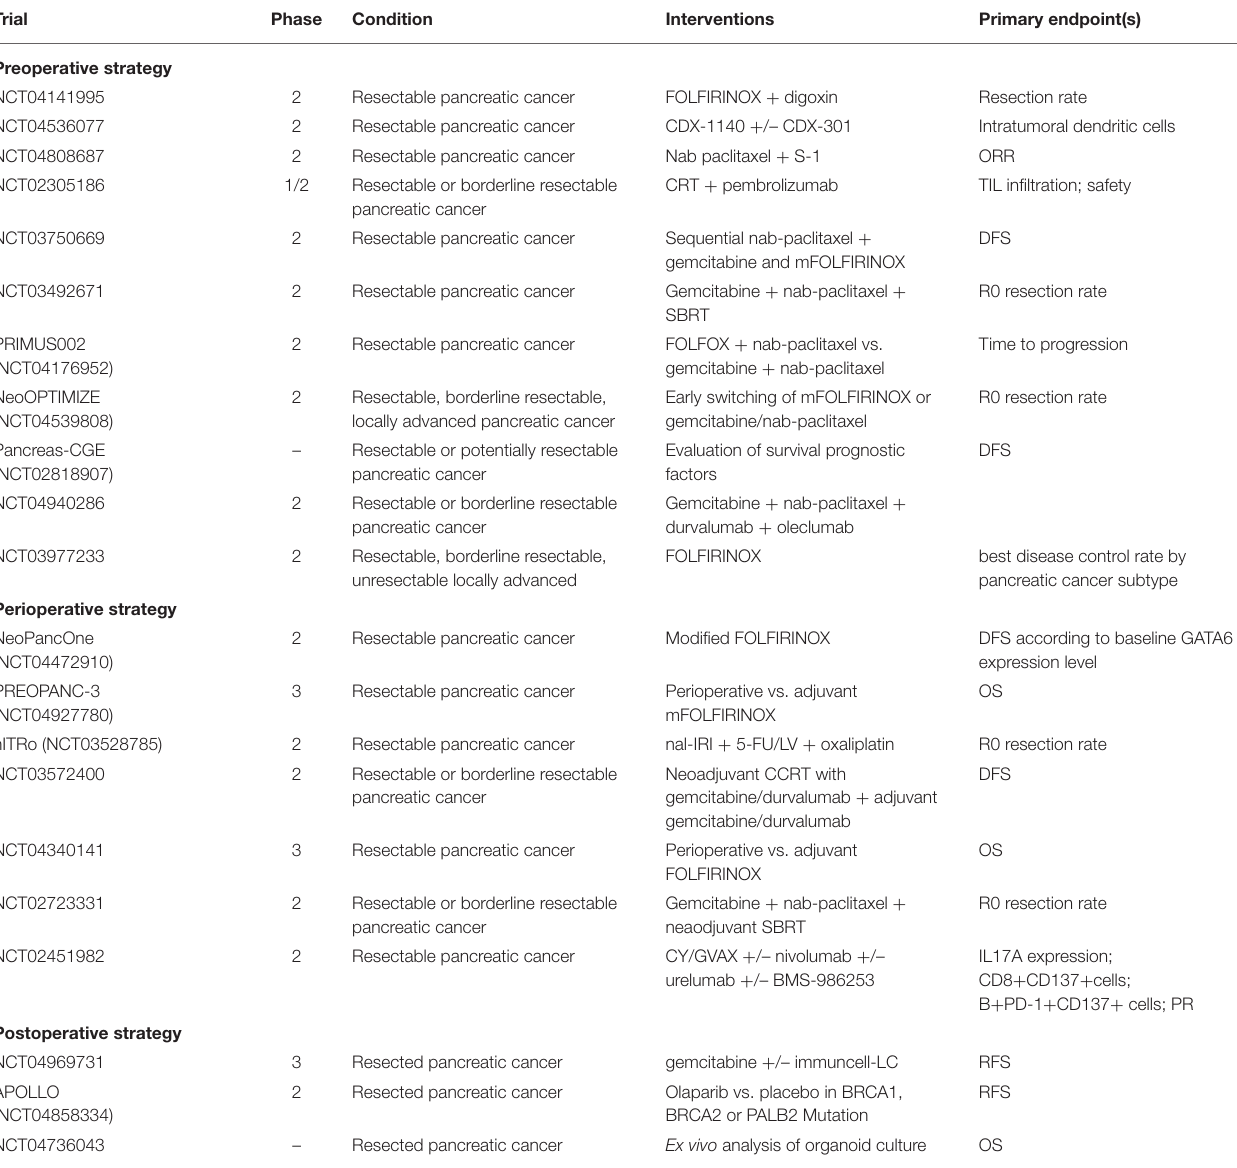
TABLE 1 | Ongoing phase II/III trials investigating systemic treatment strategies in resectable pancreatic